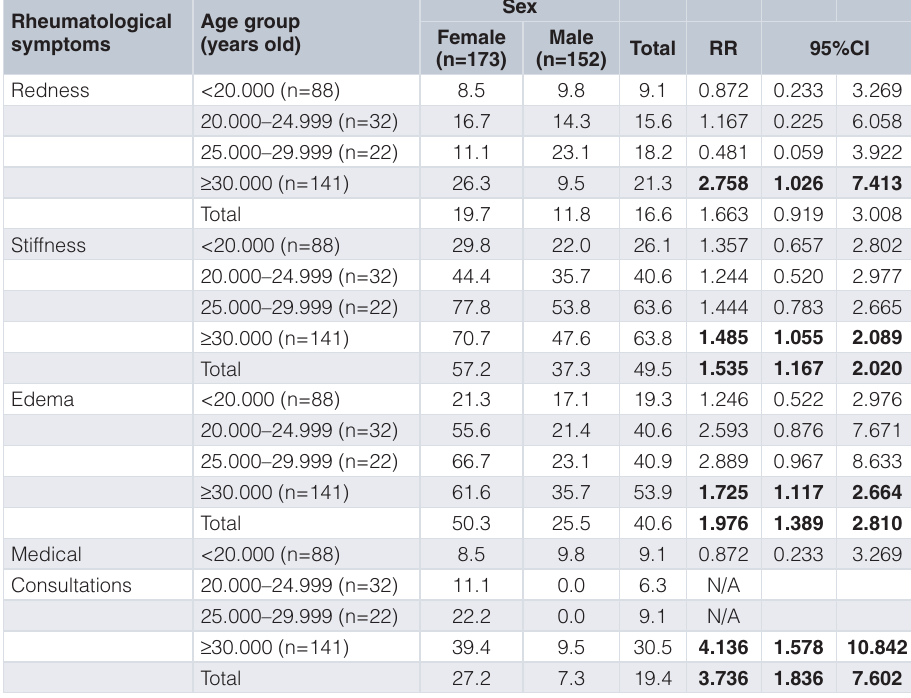
Table 2. Prevalence of other pCHIK chronic rheumatological symptoms in a cohort of La Virginia, Risaralda, Colombia; overall, by gender, and by age group. Rheumatological